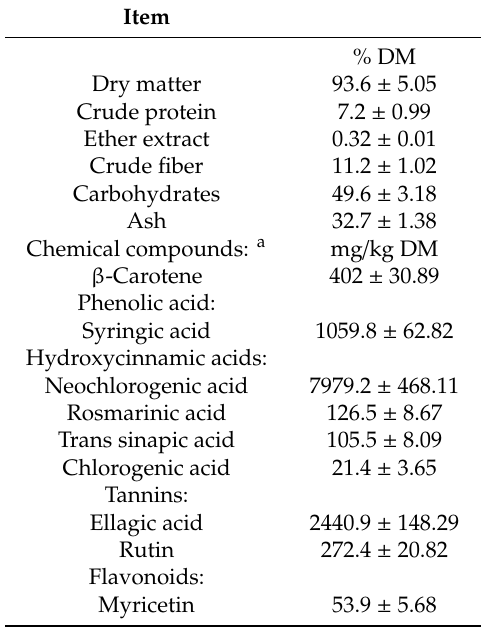
Table 2. Chemical composition and polyphenols content of the dietary